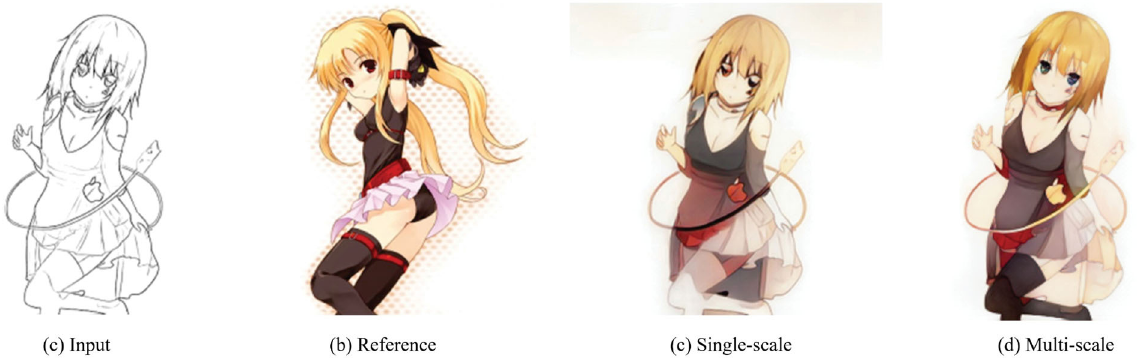
Fig. 3 Comparison with and without multi-scale outputs and